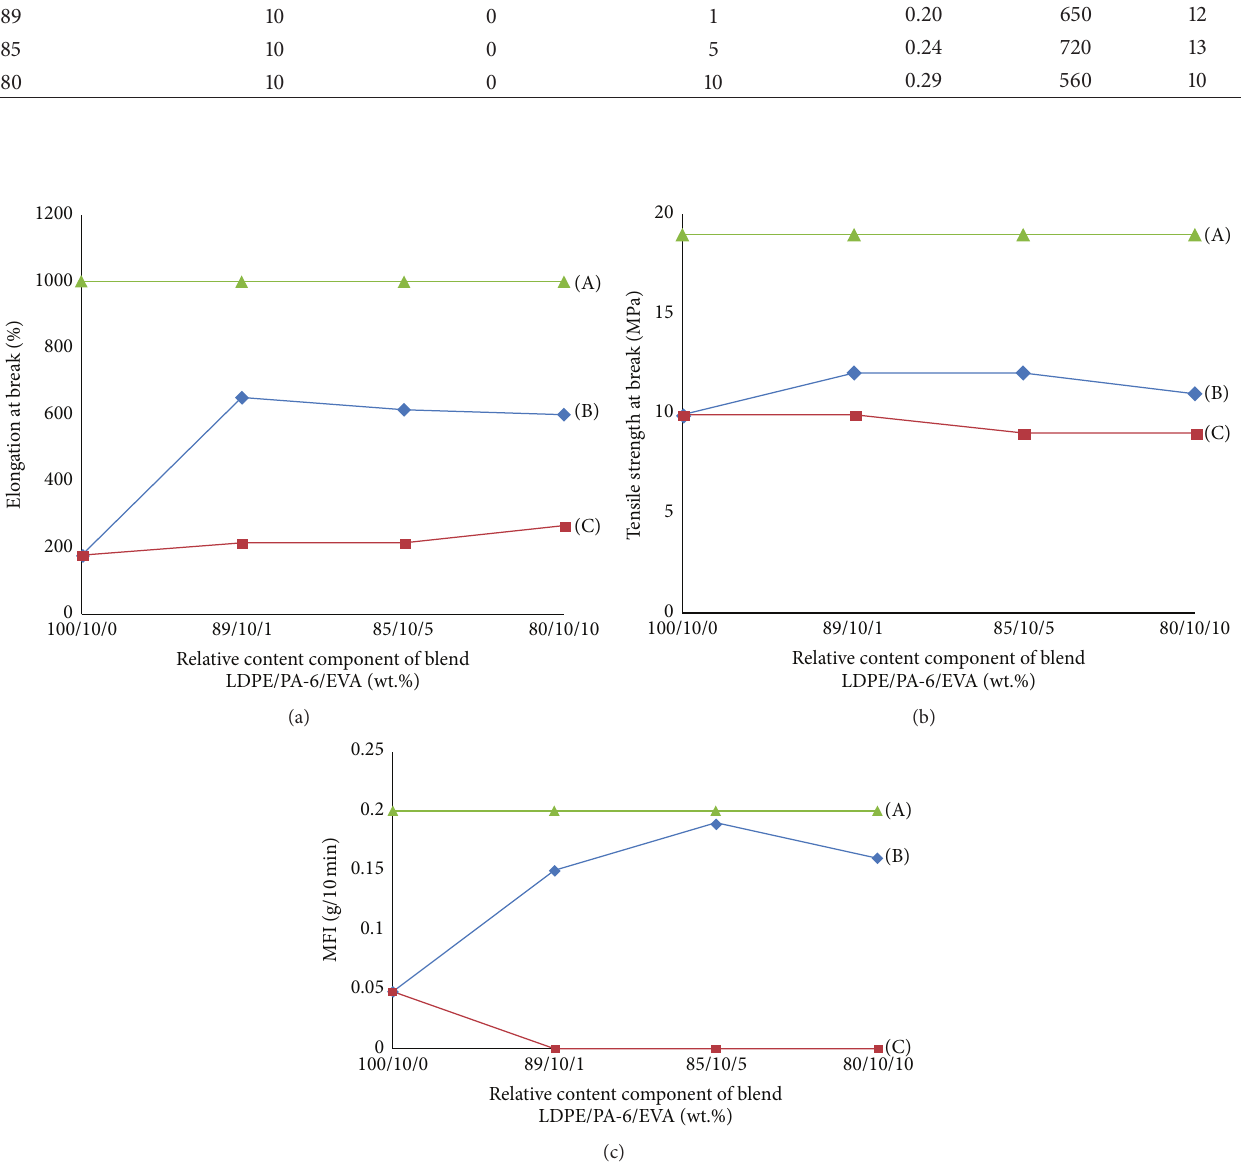
Figure 1: Estimation of the effect of different types EVA on the properties of the polymer composite of LDPE and PA-6: (A) control sample (LDPE); (B) polymer composite, containing EVA type I; (C) polymer composite, containing EVA type